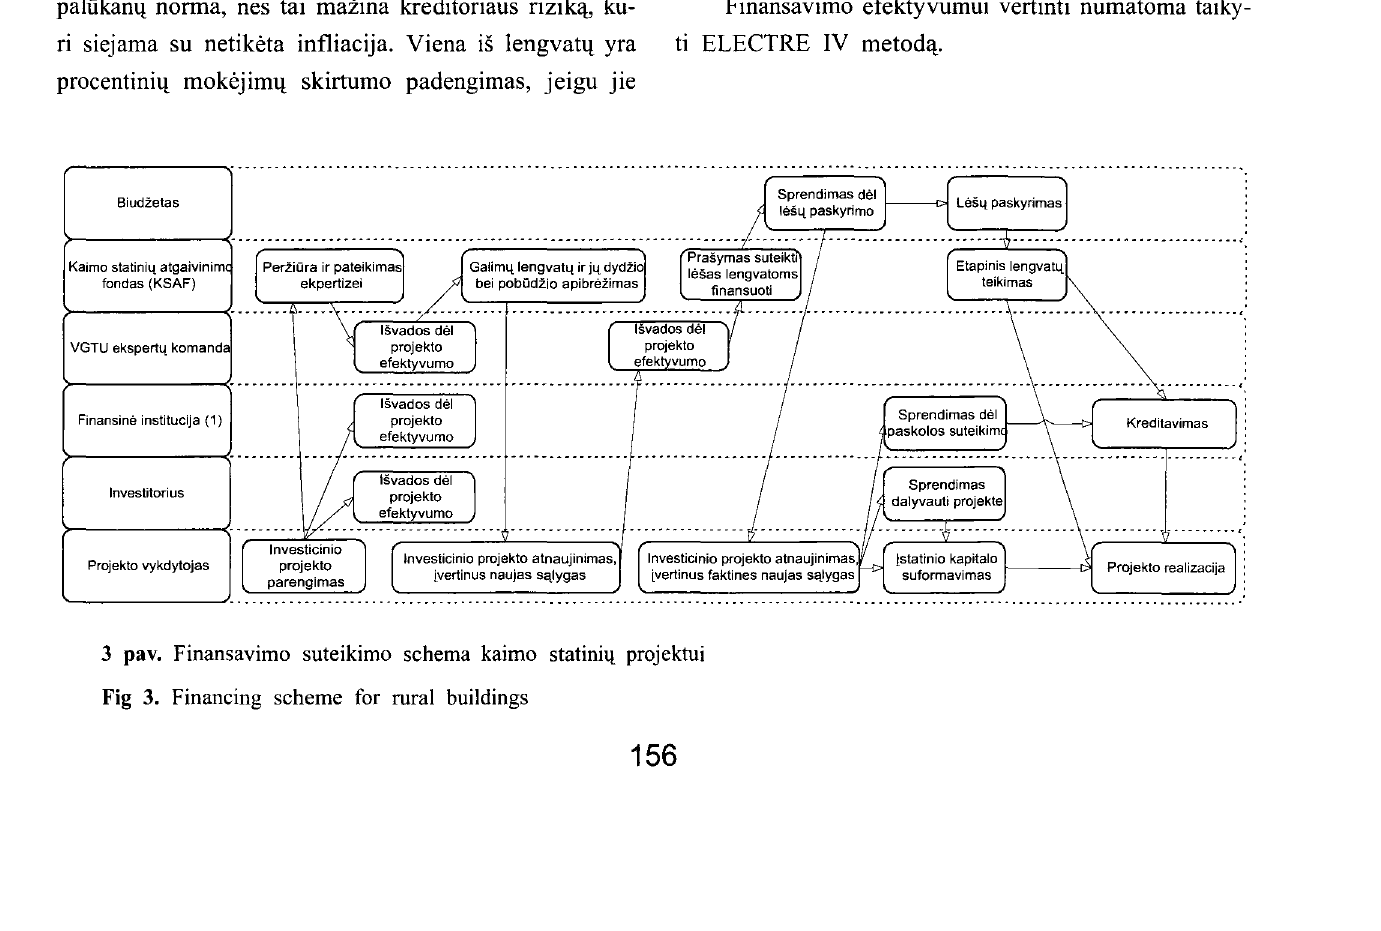
Fig 3. Financing scheme for rural